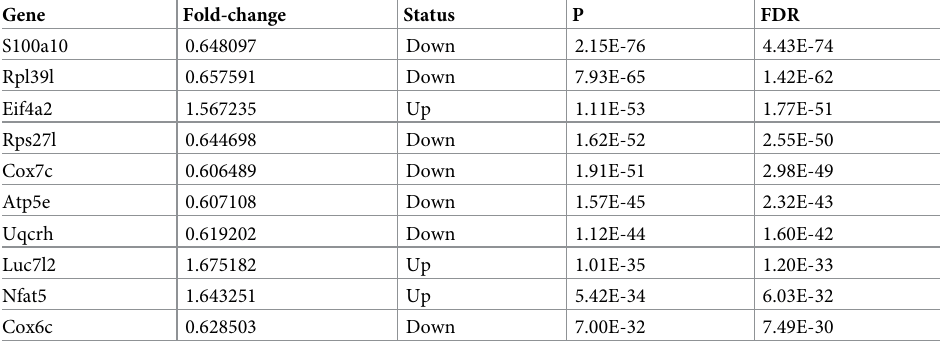
Table 1. Top 10 dysregulated mRNAs in MLO-Y4 cells treated with N.g MDP.